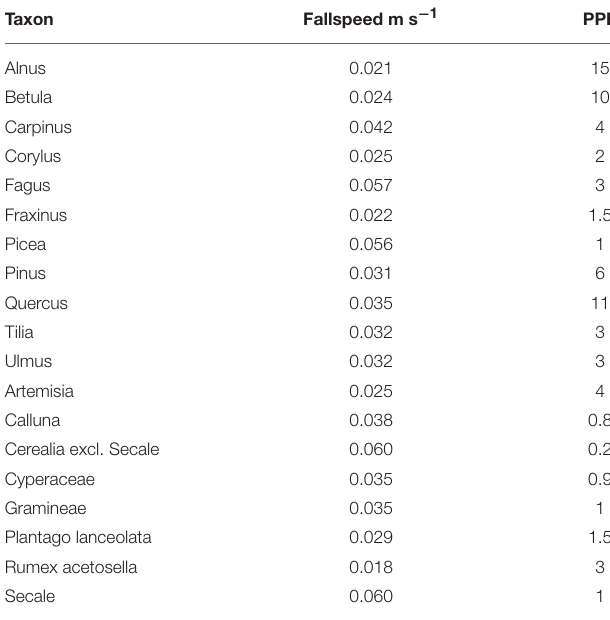
TABLE 1 | PPEs and fall speed of pollen used to prepare synthetic pollen data sets.